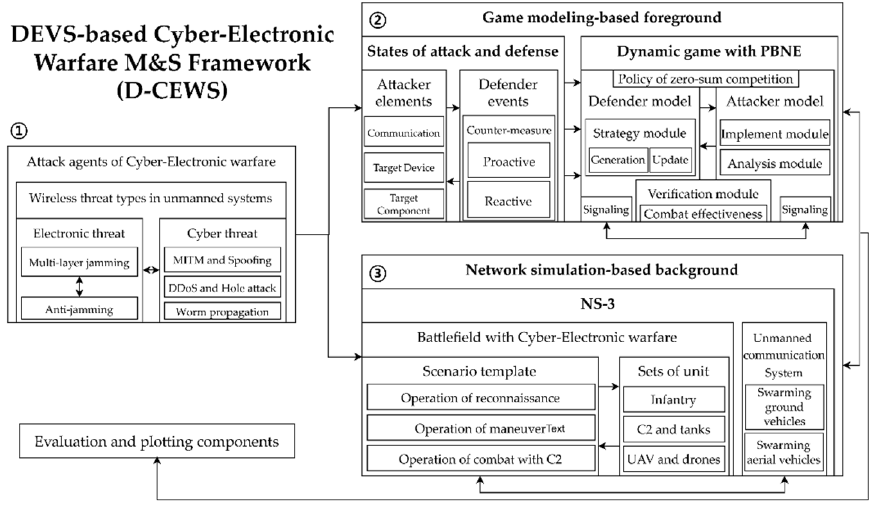
Figure 1. Main overview of D-CEWS (DEVS-based cyber-electronic warfare) framework.